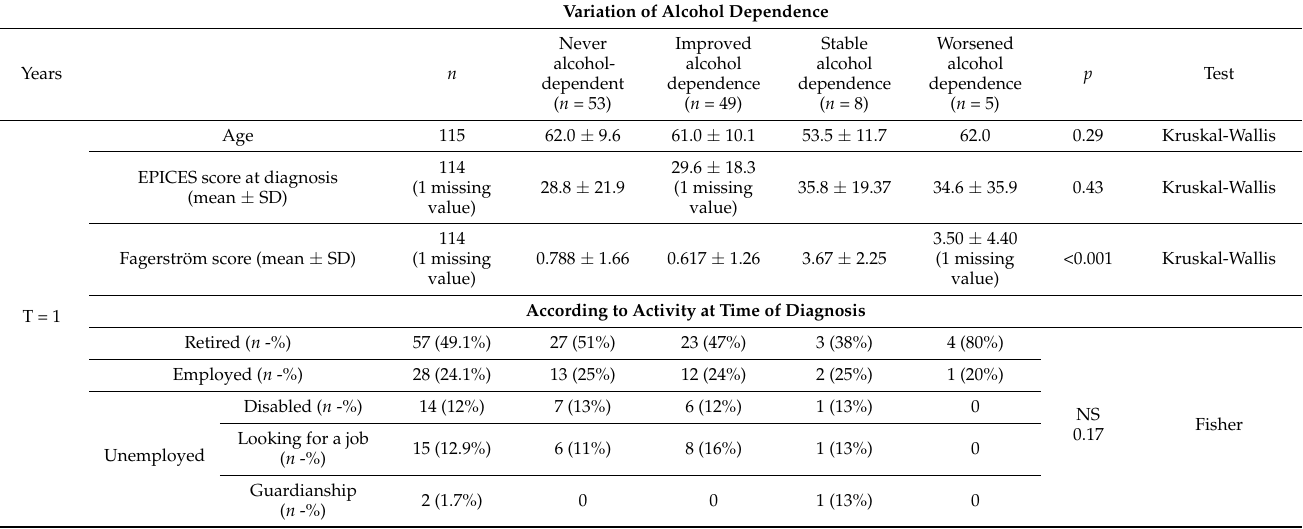
Table 5. Variation of alcohol dependence according to the CAGE score, assessed among 115/116 ever drinkers (willing to undergo the CAGE test) at the time of diagnosis and within one year from diagnosis. Variation of Alcohol